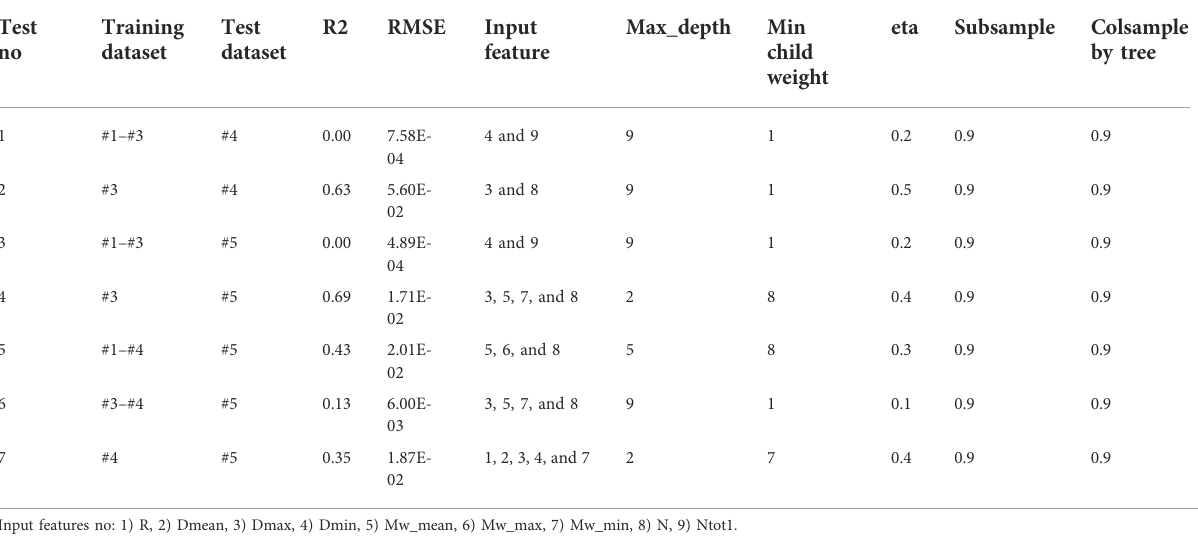
TABLE 1 Input features and hyperparameter performance.